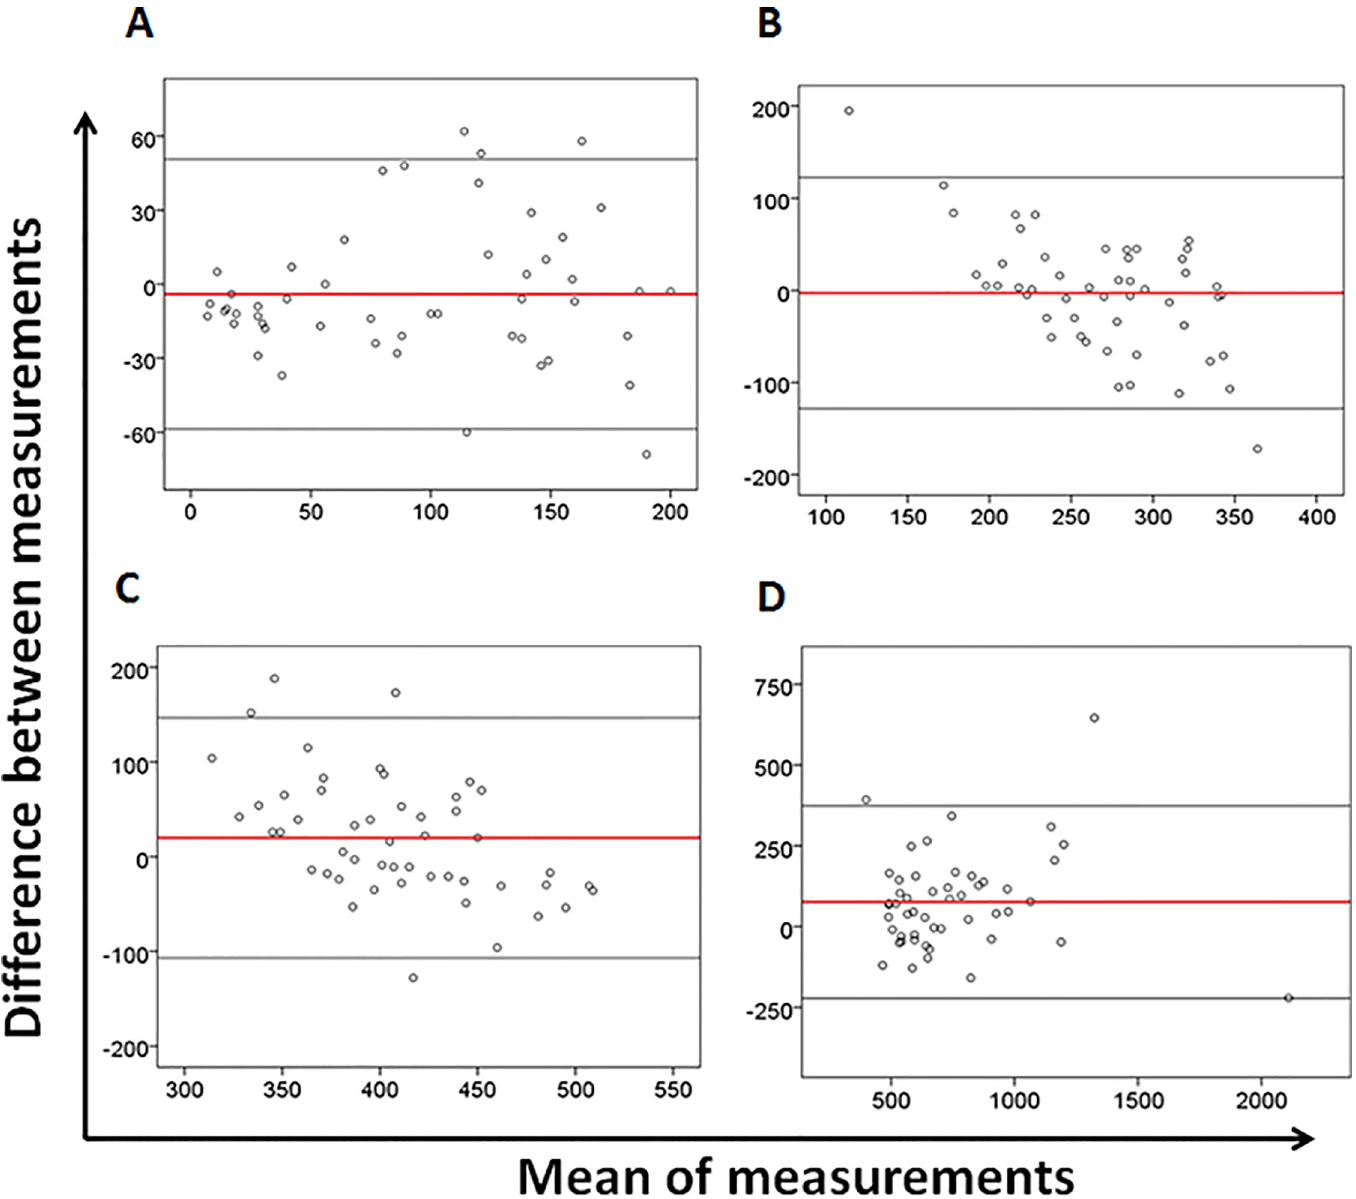
Fig 3. Bland-Altman analysis. Bland-Altman plots of (A) CD4 T-cells < 200/mm 3 , (B) between 200 and 350/mm 3 , (C) between 350 and 500/mm 3 , and (D) above 500/mm 3 according the CD4 cell count levels. For each plot, the x-axis represents the average of CD4 count between the PIMA and the BD FACSCount TM , and the y-axis represents the bias (difference) between the PIMA TM Alere and the BD FACSCount TM . The solid red line represents the mean of the difference between the two measurements, and the light black lines represent the upper and lower limits of agreement (ULA: mean differences plus and 1,96 x standard deviation of the mean difference; LLA: mean differences minus and 1,96 x standard deviation of the mean